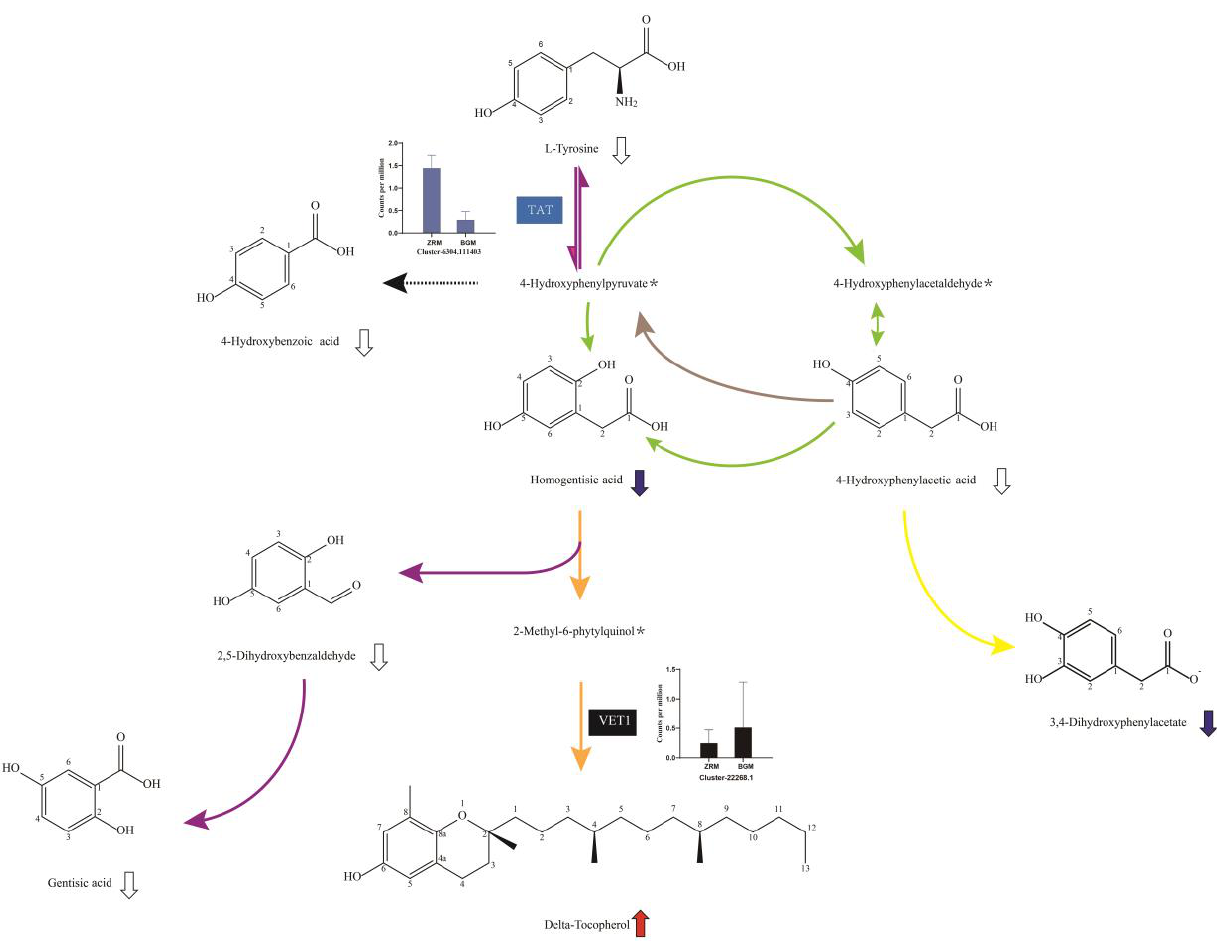
Figure 5. The metabolic pathway map of bitter phenolic acid biosynthesis in P. amarus bamboo shoots grown under shading treatment. Note: Solid arrows show a biosynthetic pathway, dashed arrow shows multiple biosynthetic pathways, white heavy arrows show downregulation of metabolites, red and blue heavy arrows show differential upregulation and downregulation of metabolites, respectively; asterisks show substances not detected in the metabolites of Pleioblastus amarus bamboo shoots. Values in the bar plots are mean of four biological replications. Error bars indicate the standard error of the mean. BGM: shading group, ZRM: control